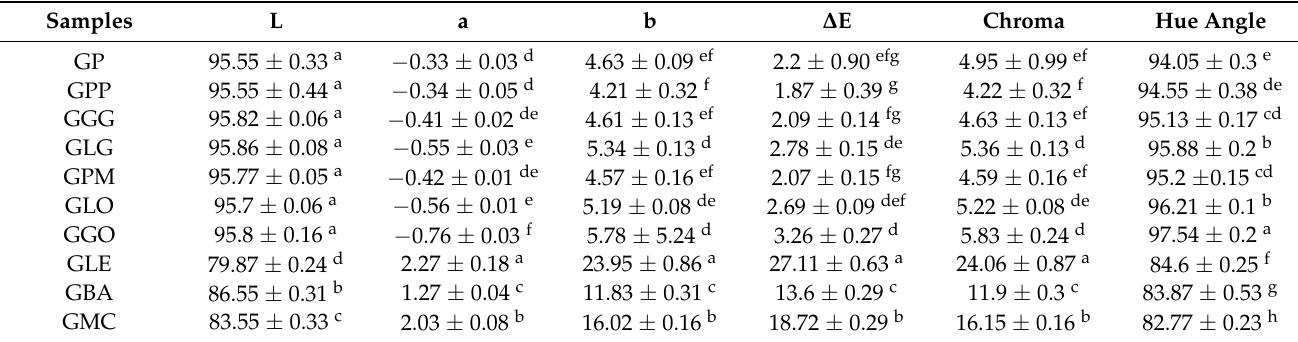
Table 2. Effects of essential oils and plant extracts on colour of the seaweed hydrocolloid and gac pulp edible films. Samples